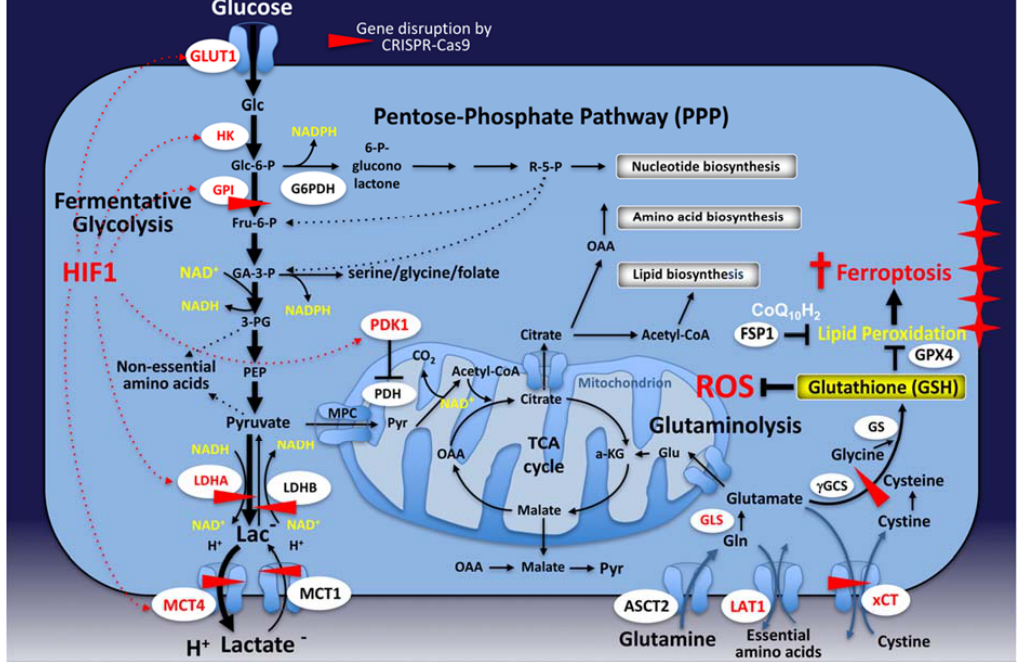
Figure 1. Note from the top—glucose to lactic acid—the three enzymatic steps that have been genetically disrupted in our studies by CRISPR-Cas9 (red horizontal triangles). Red dotted arrows represent the Hypoxia Inducible Factors (HIF)-induced genes that are upregulated during tumor hypoxia including GLUT1 , HK , GPI , LDHA , MCT4 and PDK1 , thereby allowing tumors to have a sustained fermentative glycolysis capacity. Glutathione peroxidase 4 (GPX4) and ferroptosis suppressor protein 1 (FSP1), which is a novel glutathione-independent ferroptosis suppressor, are also depicted in this scheme; both of them prevent the generation of membrane lipid peroxides.